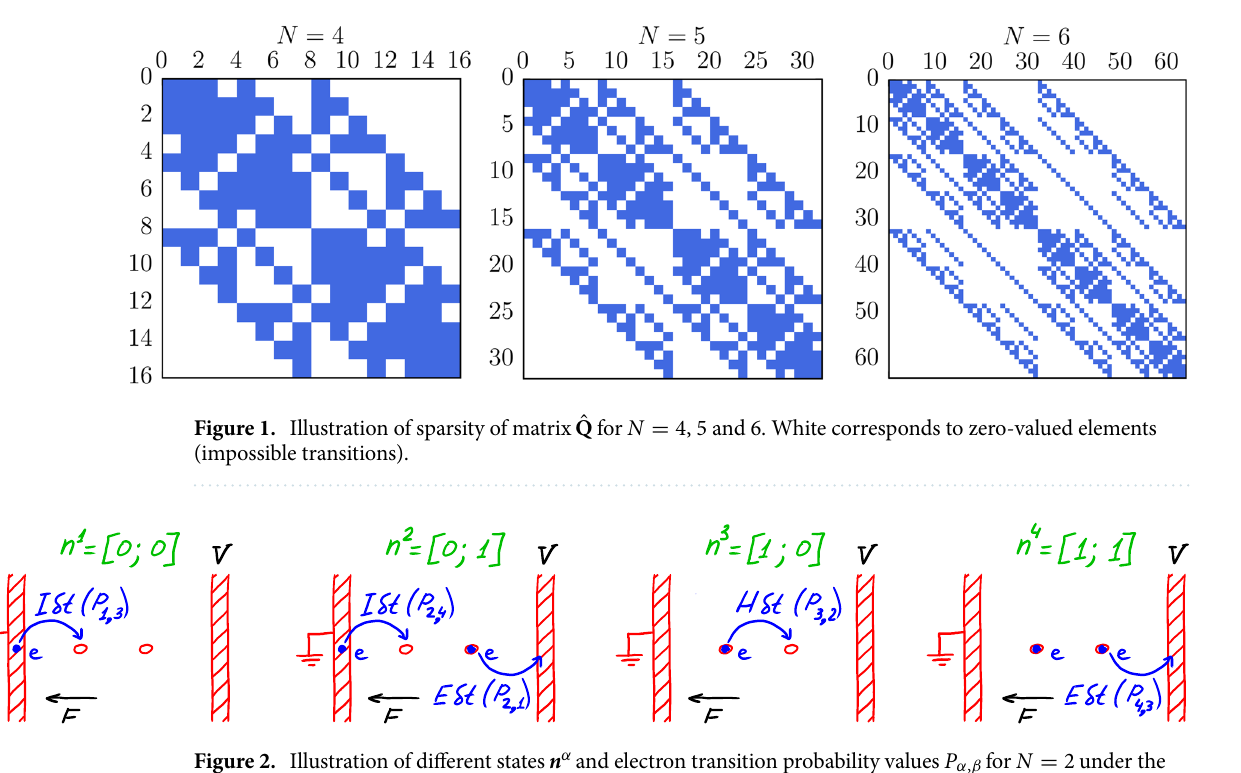
Figure 2. Illustration of different states n α and electron transition probability values P α , β for N = 2 under the strong right-to-left electric